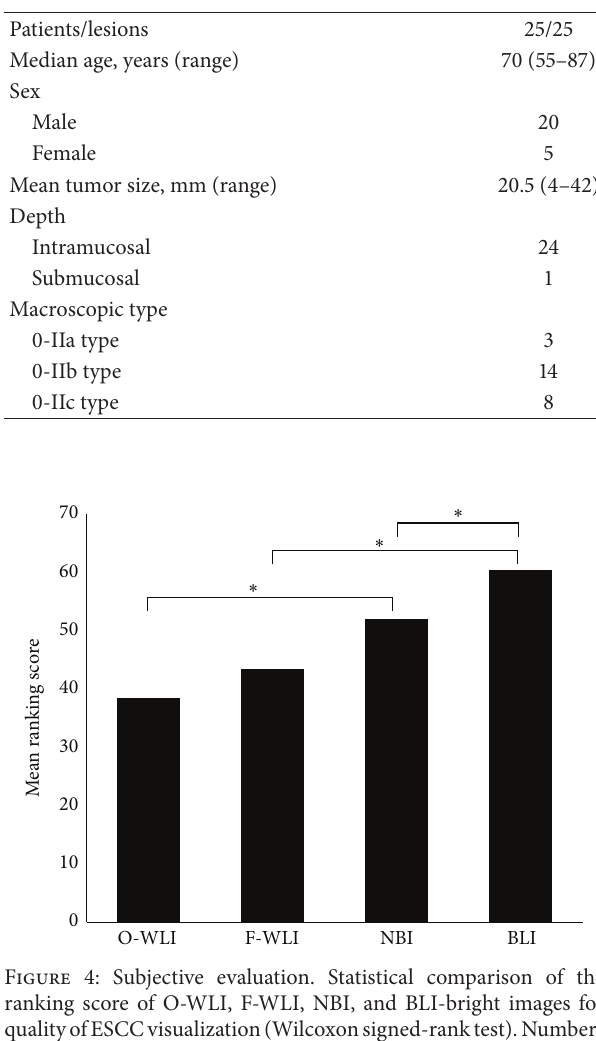
Table 1: Clinicopathological features of patients.